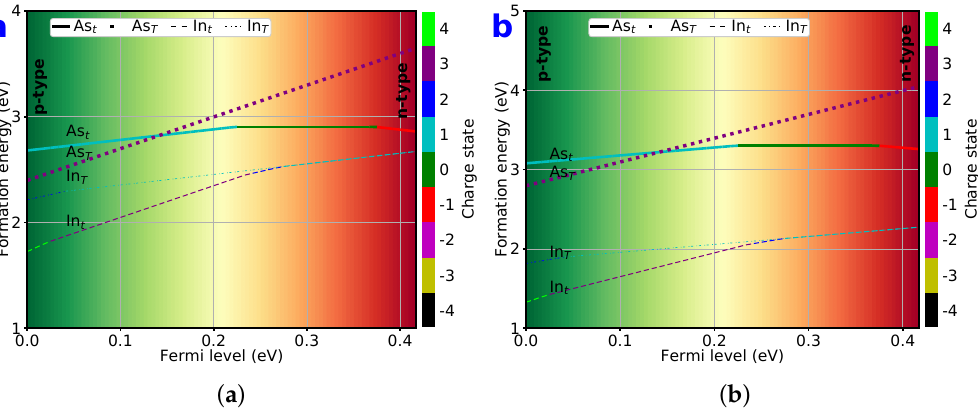
Figure 5. Formation energies as functions of E F in the ( a ) As-rich and ( b ) In-rich environment for four tetrahedral-site interstitial type point defects in zb -InAs with all possible charge states from − 4 to + 4 marked with different colors. The y-axises are enlarged for viewing